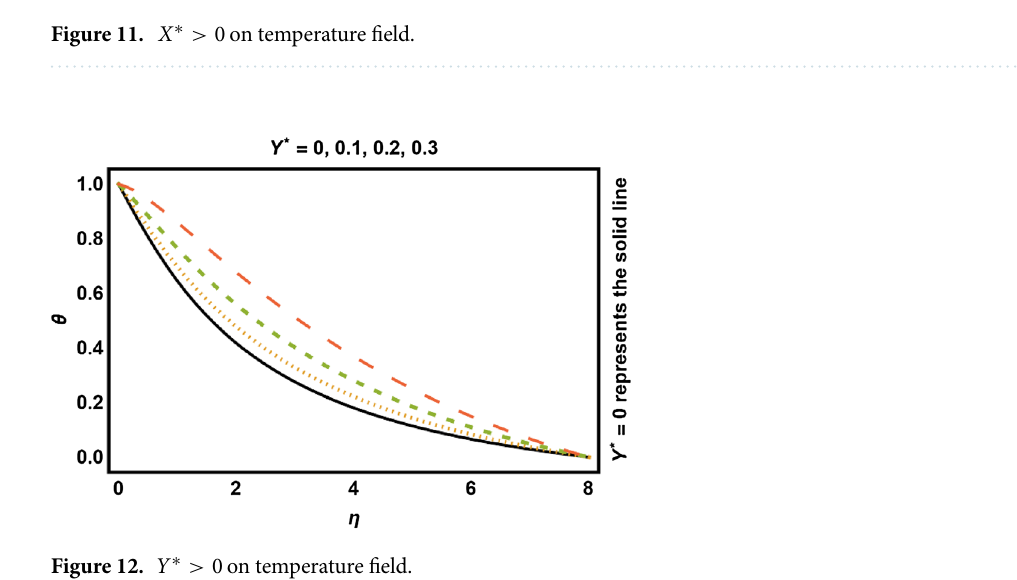
Figure 12. Y ∗ > 0 on temperature